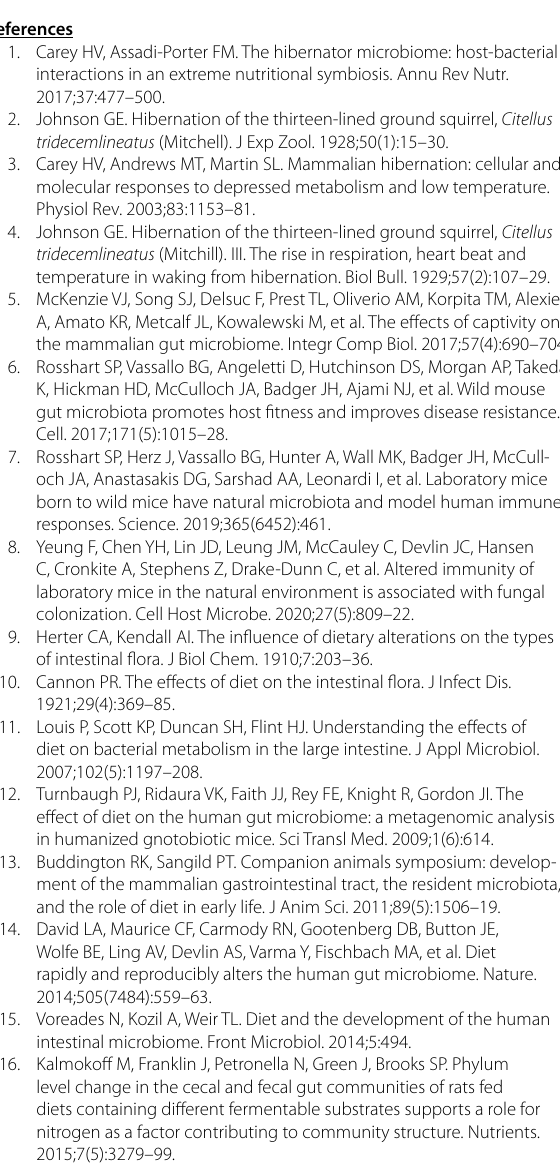
Table S7. Phyla relative abundances in summer Captive and Wild content microbiotas. Phyla have total relative abundances > 1% and are displayed from overall highest relative abundance to lowest relative abundance. Relative abundances are displayed as mean standard error and adjusted ± p-values are from t-tests or Wilcoxon Rank Sum tests, depending on data normality. Table S8. OTUs that significantly contribute to Bray-Curtis dissimilarity between Captive and Wild content microbiotas. OTUs were identified with SIMPER and statistically tested with Kruskal-Wallis tests. P-values were corrected for false discovery rate using the Benjamini-Hoch- berg procedure. Only OTUs that accounted for 1% of the differences in ≥ beta diversity and had adj P < 0.05 were considered significant. Table S9. Core OTUs in summer Captive and Wild mucosa microbiotas. X’s in a Captive or Wild column indicate that the OTU is a core OTU in that group, while empty cells indicate that the OTU is not a core OTU in the group. Table S10. Core OTUs in summer Captive and Wild content microbiotas. X’s in a Captive or Wild column indicate that the OTU is a core OTU in that group, while empty cells indicate that the OTU is not a core OTU in the group. Table S11. Phyla relative abundances in content micro- biotas of captive groups. Phyla have total relative abundance >1% and are displayed from overall highest relative abundance to lowest relative abundance. Relative abundances are displayed as mean standard error ± and adjusted p-values are from ANOVA and Tukey’s HSD tests, or Kruskal- Wallis and Dunn’s tests, depending on data normality. Table S12. Core OTUs in mucosa microbiotas across captive groups. X’s in a captive group column indicate that the OTU is a core OTU in that group, while empty cells indicate that the OTU is not a core OTU in the group. Table S13. Core OTUs in content microbiotas across captive groups. X’s in a captive group column indicate that the OTU is a core OTU in that group, while empty cells indicate that the OTU is not a core OTU in the